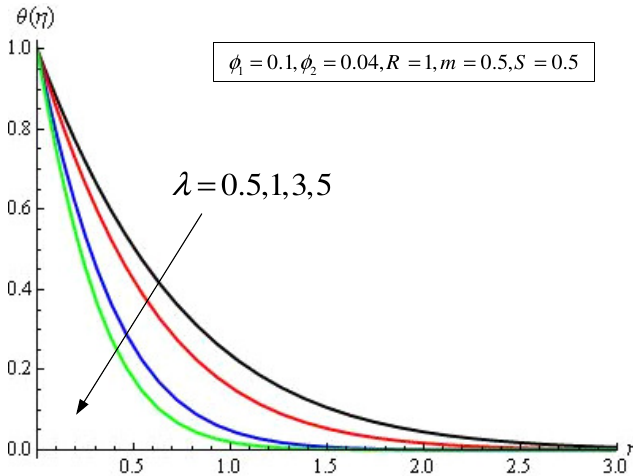
Figure 4. Effects of λ on the temperature distributions of the hybrid nanofluid.